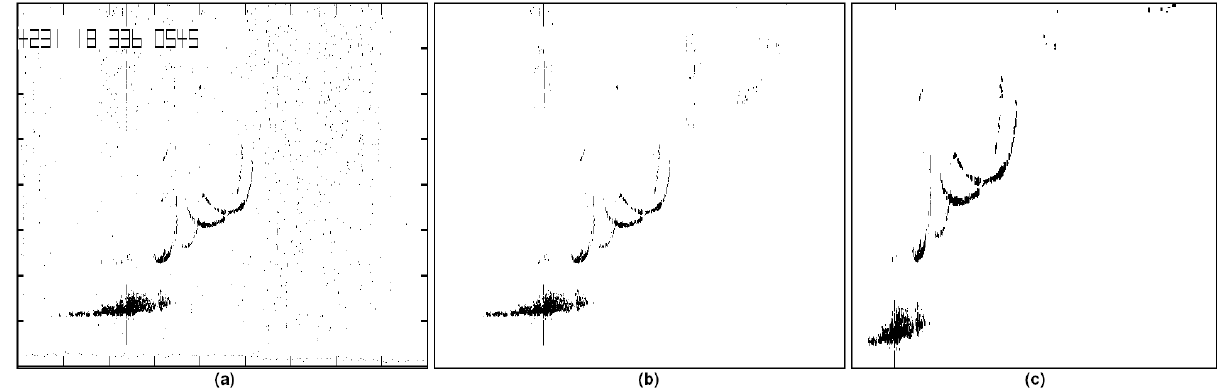
Figure 6. ( a ) The original ionogram obtained by IPS-42 on 2 December 2018 at 05:45 LT, ( b ) the result of noise, ticks, and labels removal, ( c ) the result of interpolation and binarization. Additional information can be found in Supplementary Materials.